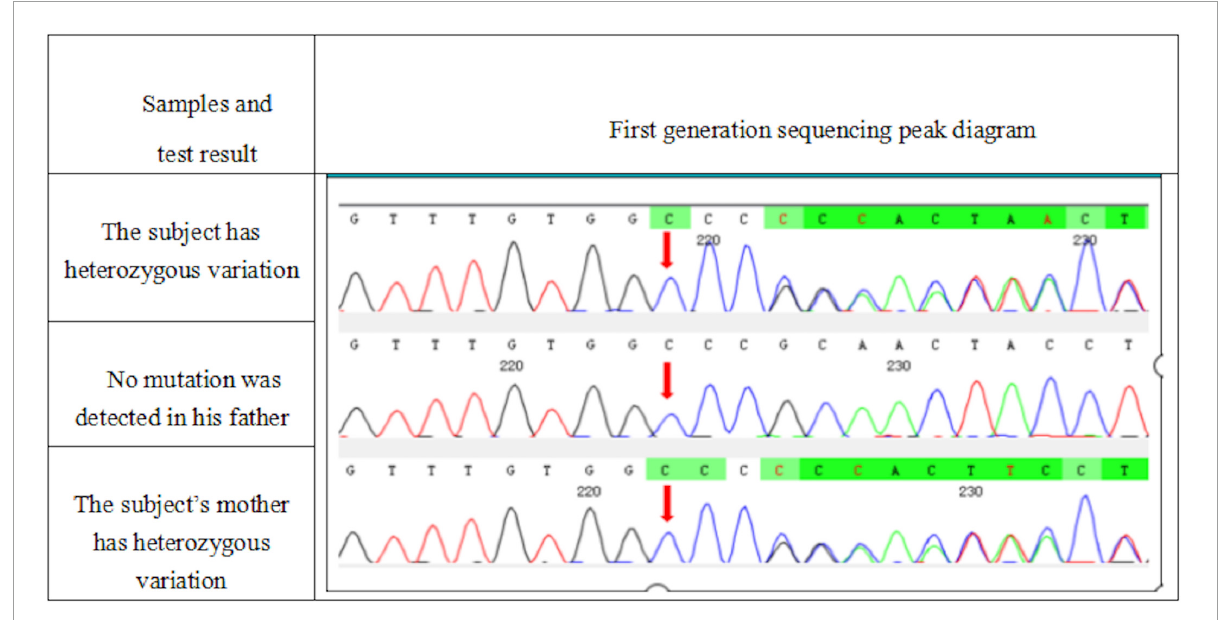
FIGURE5 A heterozygous mutation c. 2962dup:p.R988Pfs *15 appeared in the ATP2A2 gene of the subject. This mutation was a duplication of the 2,962 base of cDNA, resulting in the change of the 988 codon from encoding arginine to encoding proline, and then, a stop codon was generated in advance.